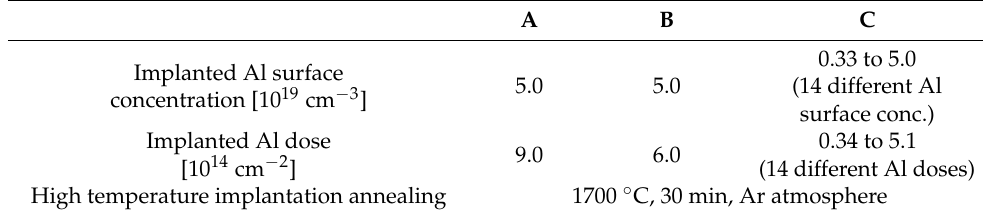
Table 1. Parameters of the fabricated sets of